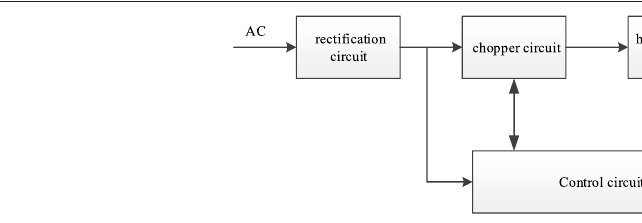
FIGURE 1 | Block diagram of the electric bicycle charger.